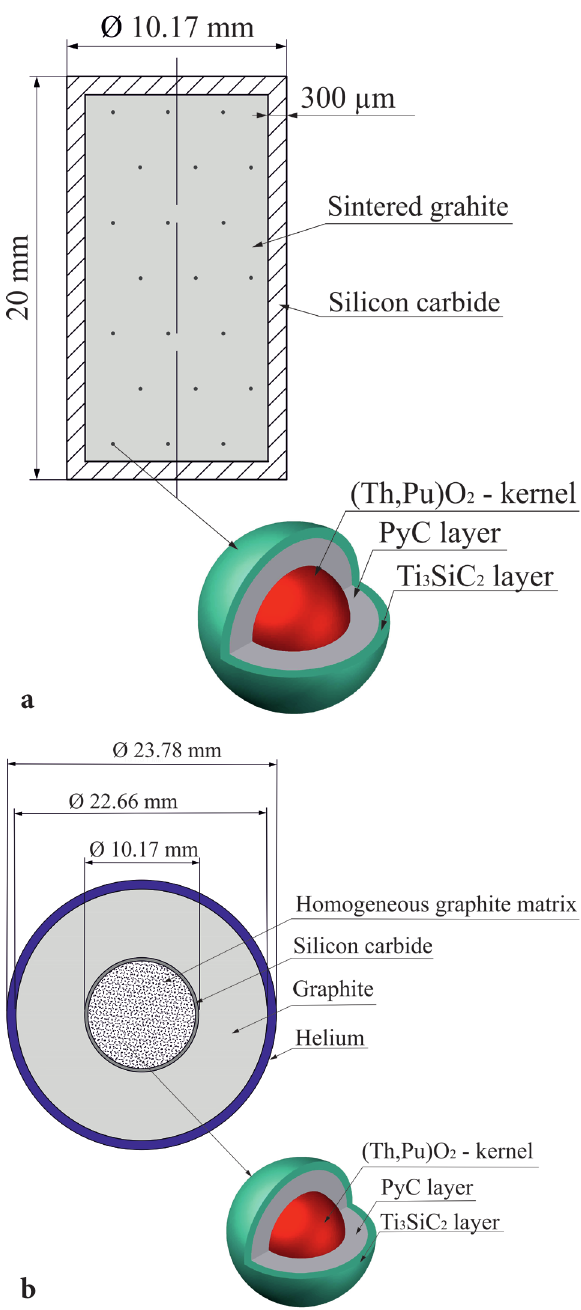
Figure 1. Fuel pellet of the type 1017 (a) and a 2D computation - al model of the equivalent cell